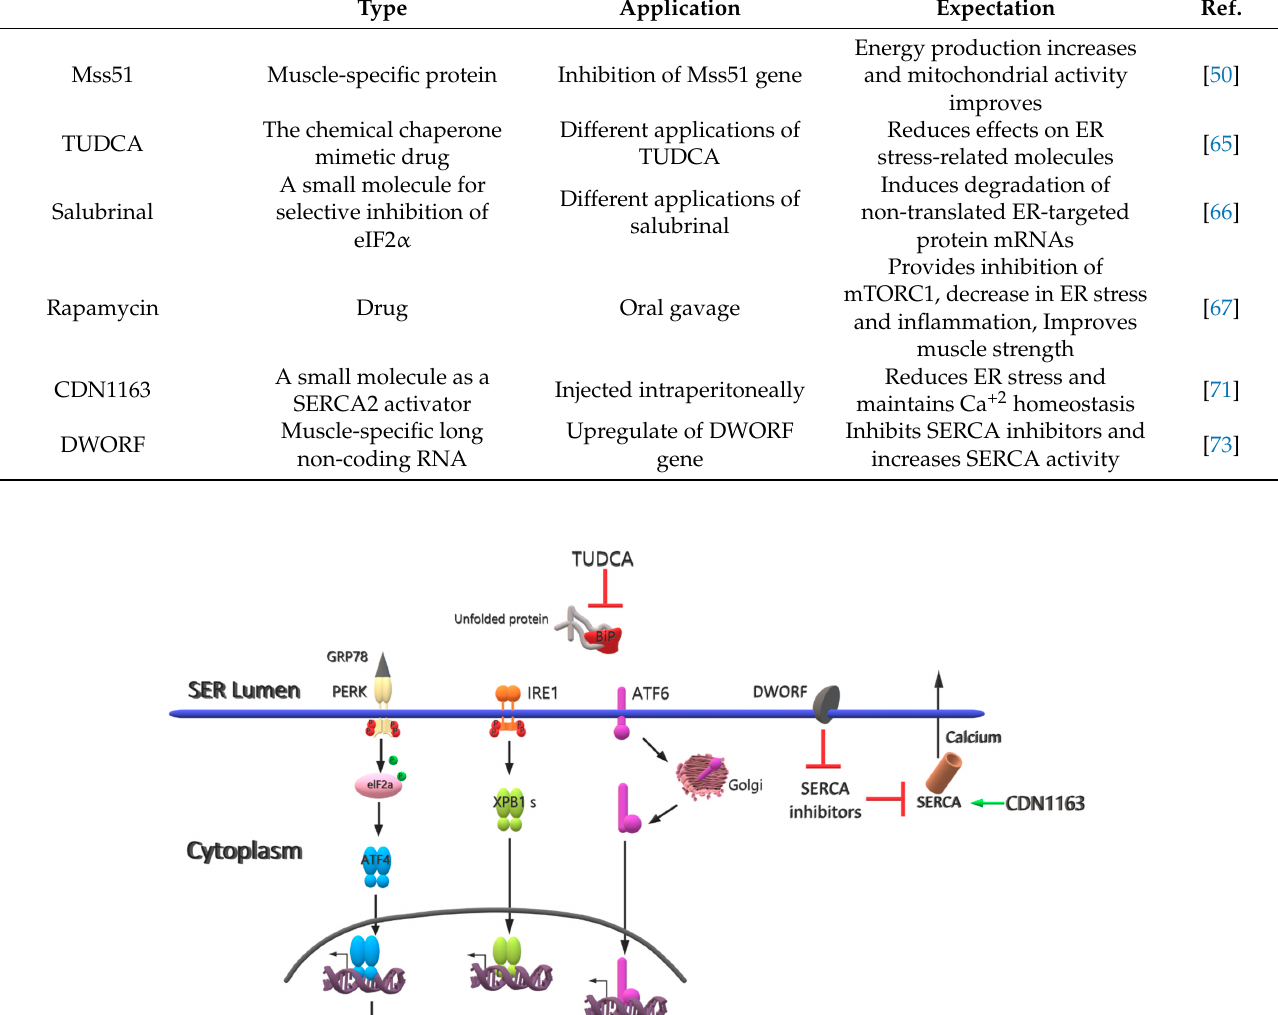
Table 2. Future therapy strategies.